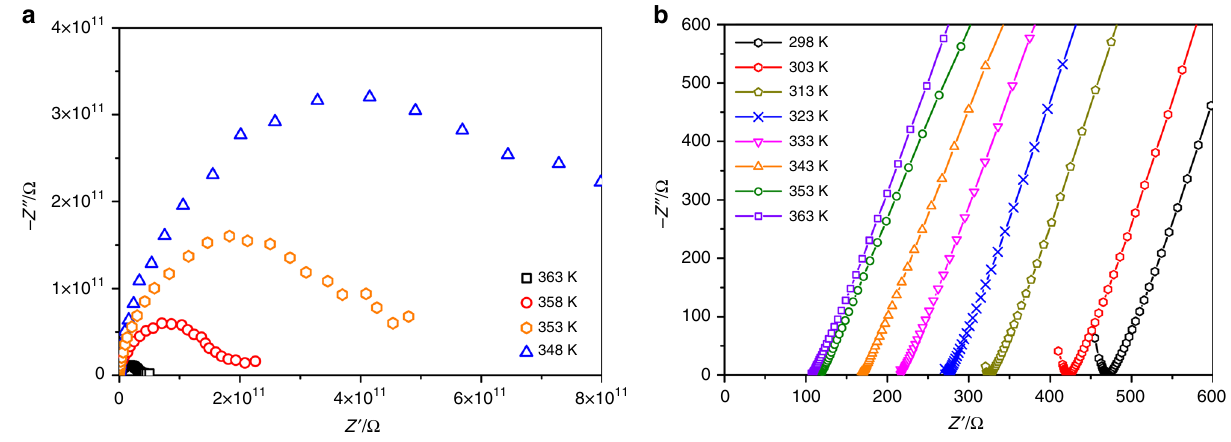
Fig. 2 Nyquist plots from AC impedance data for MIP-202(Zr). a at 0% RH. b at 95%